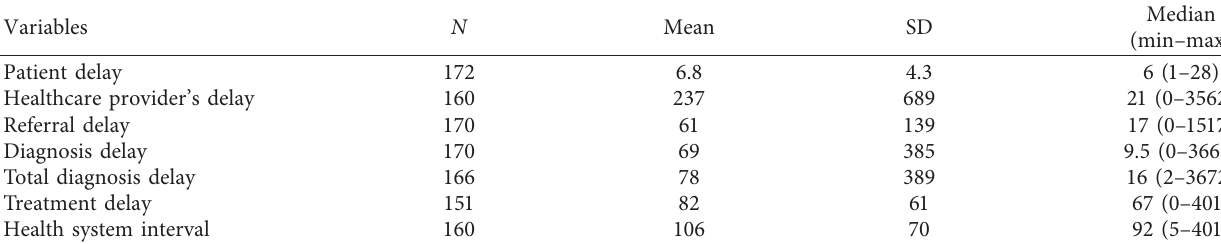
Table 2: Care pathway delays.